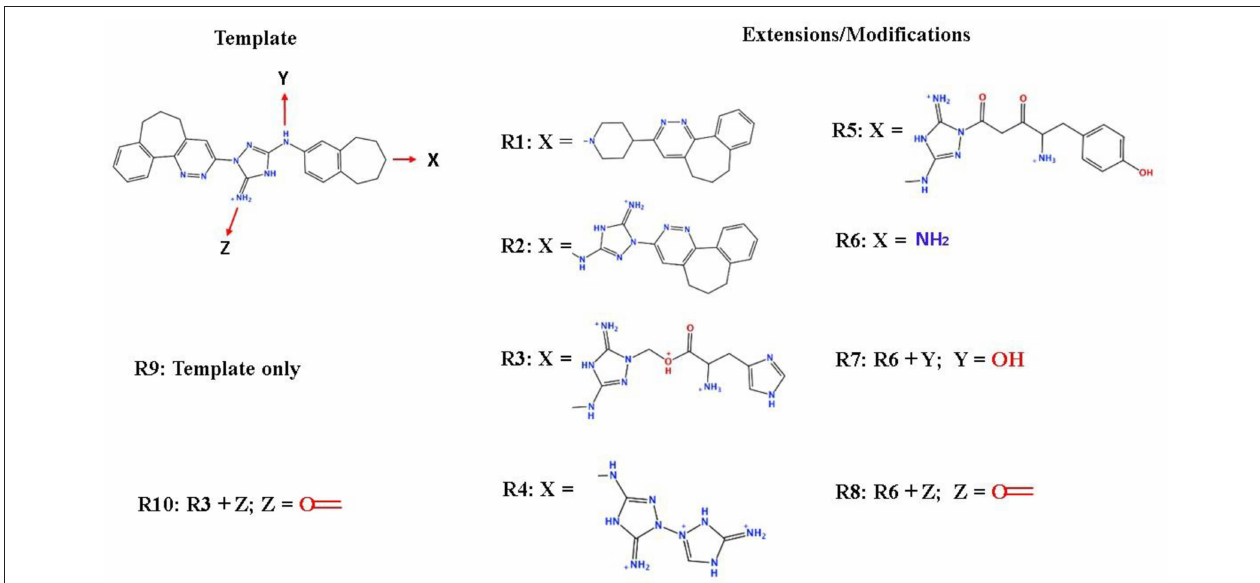
FIGURE 4 | The design strategy of the new compounds starting from the R428_1 compound (see Table 3 ). The upper-left part is an invariant part of the compound used as a template. The upper/lower right and lower left parts are extensions/modifications of the